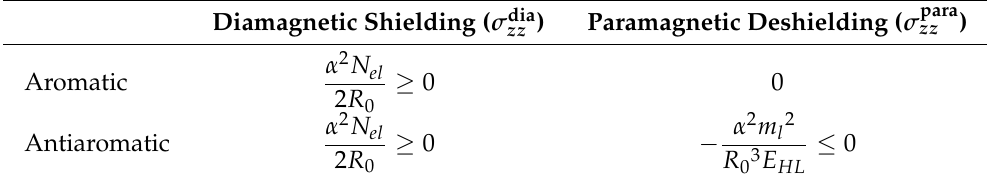
Table 1. Diamagnetic and paramagnetic shielding contributions computed at the centre of a 2D rigid rotor in terms of the number of electrons ( N el ), the radius ( R 0 ), the angular momentum quantum number ( m l ) of the HOMO and LUMO, and the HOMO/LUMO gap ( E HL ). Diamagnetic Shielding ( σ dia ) Paramagnetic Deshielding ( σ para zz ) zz α 2 N el ≥ 0 0 Aromatic 2 R 0